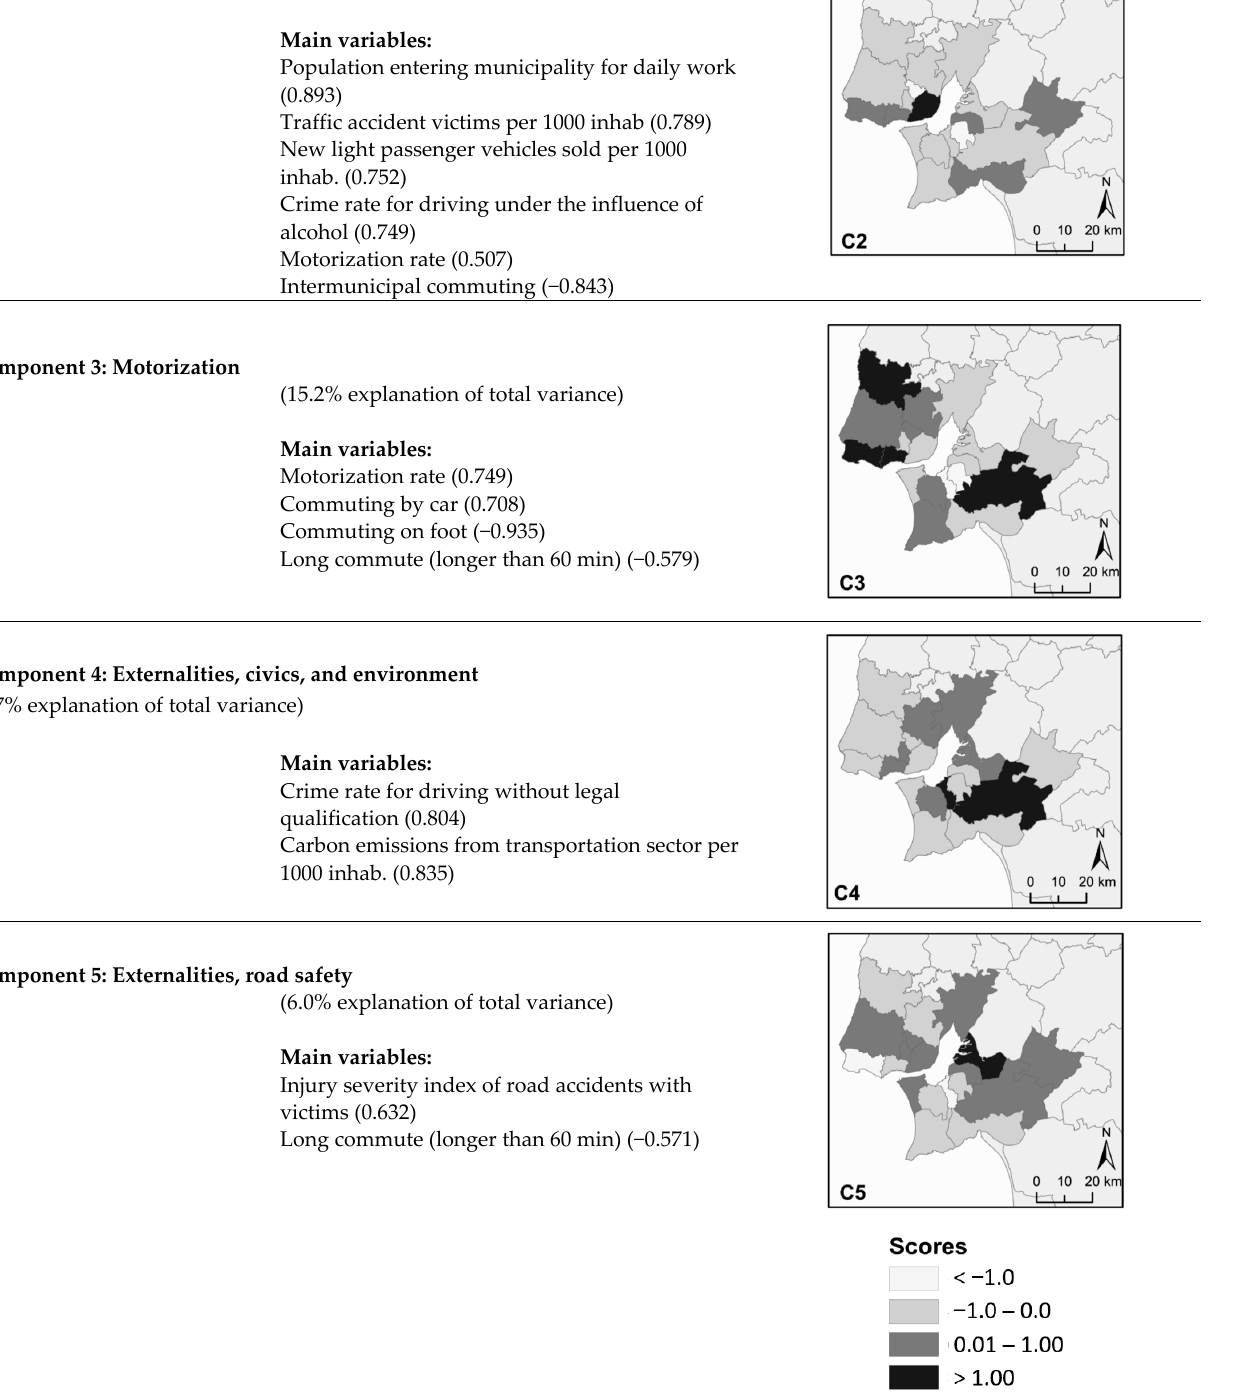
Figure 4. Principal component analysis (PCA) components, explanation of total variance, main variables, and spatial representation of each component in Lisbon Metropolitan Area (LMA) municipalities.